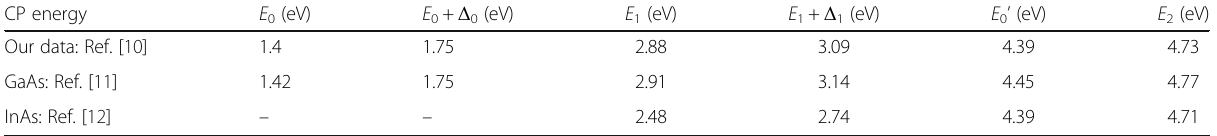
Table 1 Comparison between the different CP energies of GaAs and InAs obtained in our previous work and those in Refs. [11, 12] CP energy